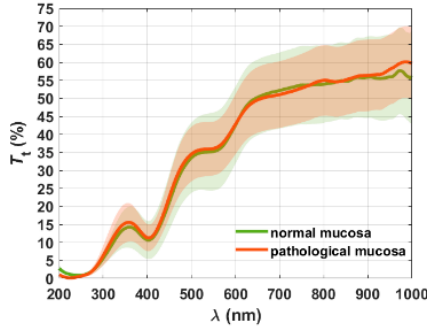
Figure 4. Mean T t spectra of the normal and pathological mucosa.